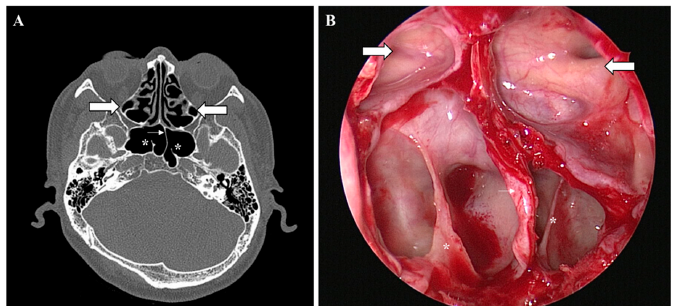
Figure 3. Onodi cell, vertical intersphenoid sinus septum, and ridge. Non-enhanced preoperative paranasal sinus computed tomography scan and endoscopic view of Onodi cell (large arrow), left vertical intersphenoid sinus septation (small arrow), and bilateral ridge (*): ( A ) PNS CT axial view and ( B ) endoscopic view during EETSA-based surgery.